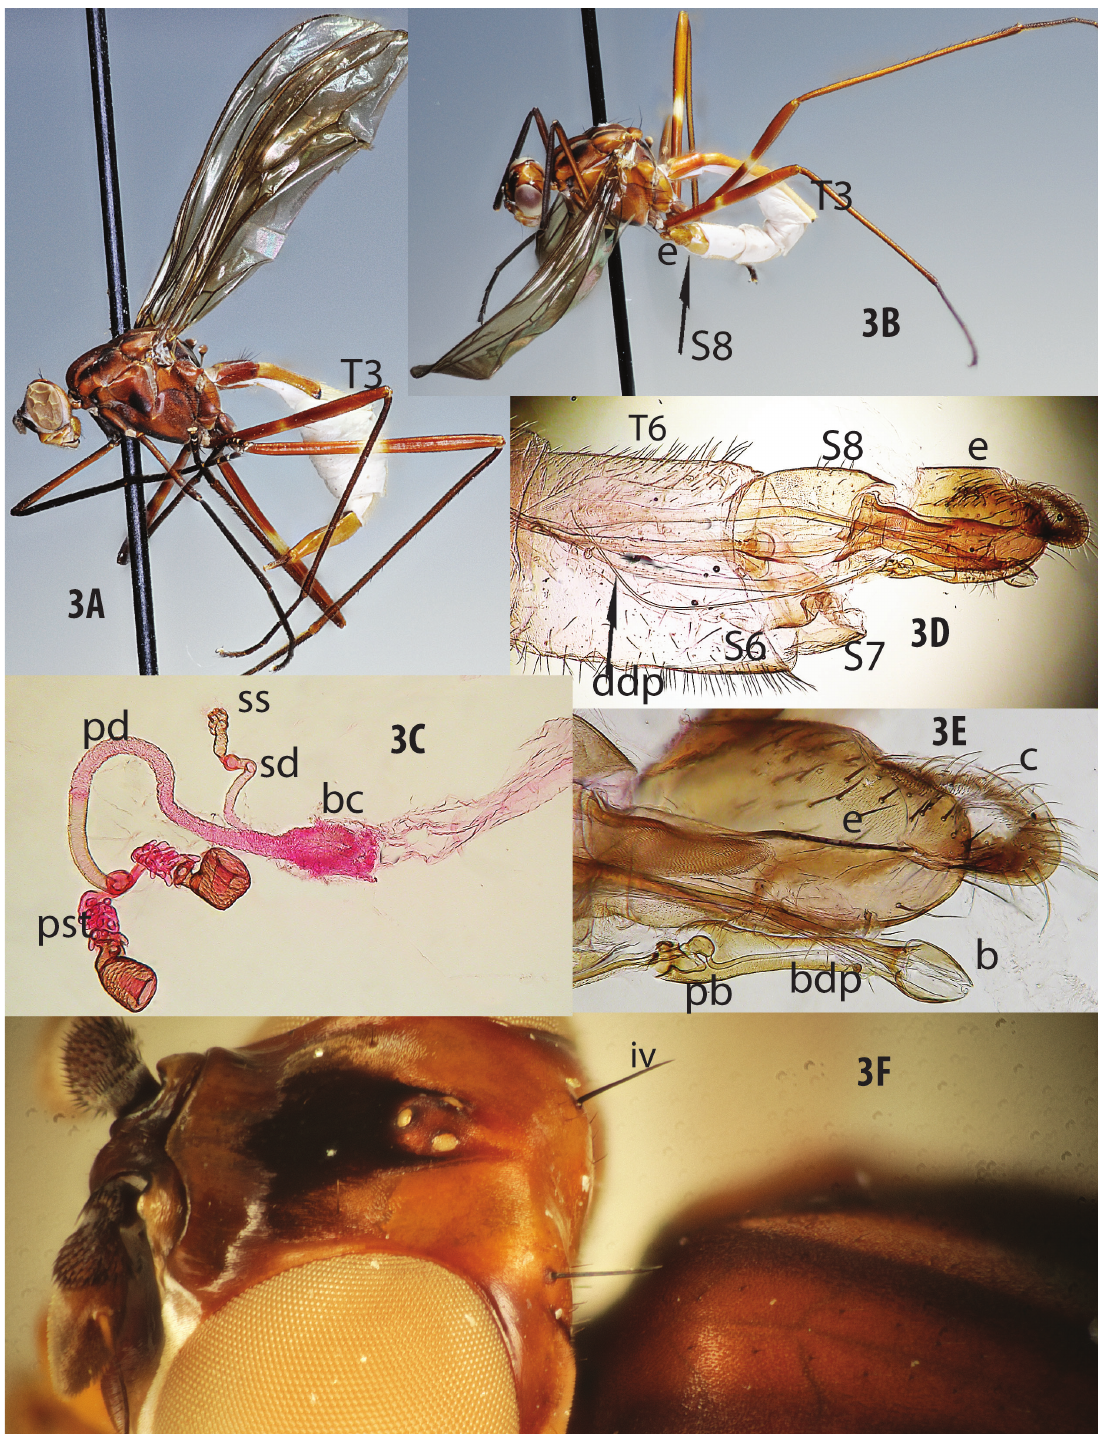
Fig. 3. Mesoconius albitergum sp. nov . A . ♀. B . Holotype, ♂, IAVH. C . Spermatheca and associated structures. D . Abdominal apex, ♂, lateral view. E . Male terminalia, lateral view but with phallus twisted (basiphallus 90° left, distiphallus 180°). F . Head and thorax, ♀. Abbreviations: b = basiphallus; bc = bursa copulatrix; bdp = basal distiphallus; c = cercus; ddp = distal distiphallus; e = epandrium; iv = inner vertical bristle; pb = phallic bulb; pd = paired spermathecal duct; pst = paired spermathecal duct; sd = single spermathecal duct; ss = single